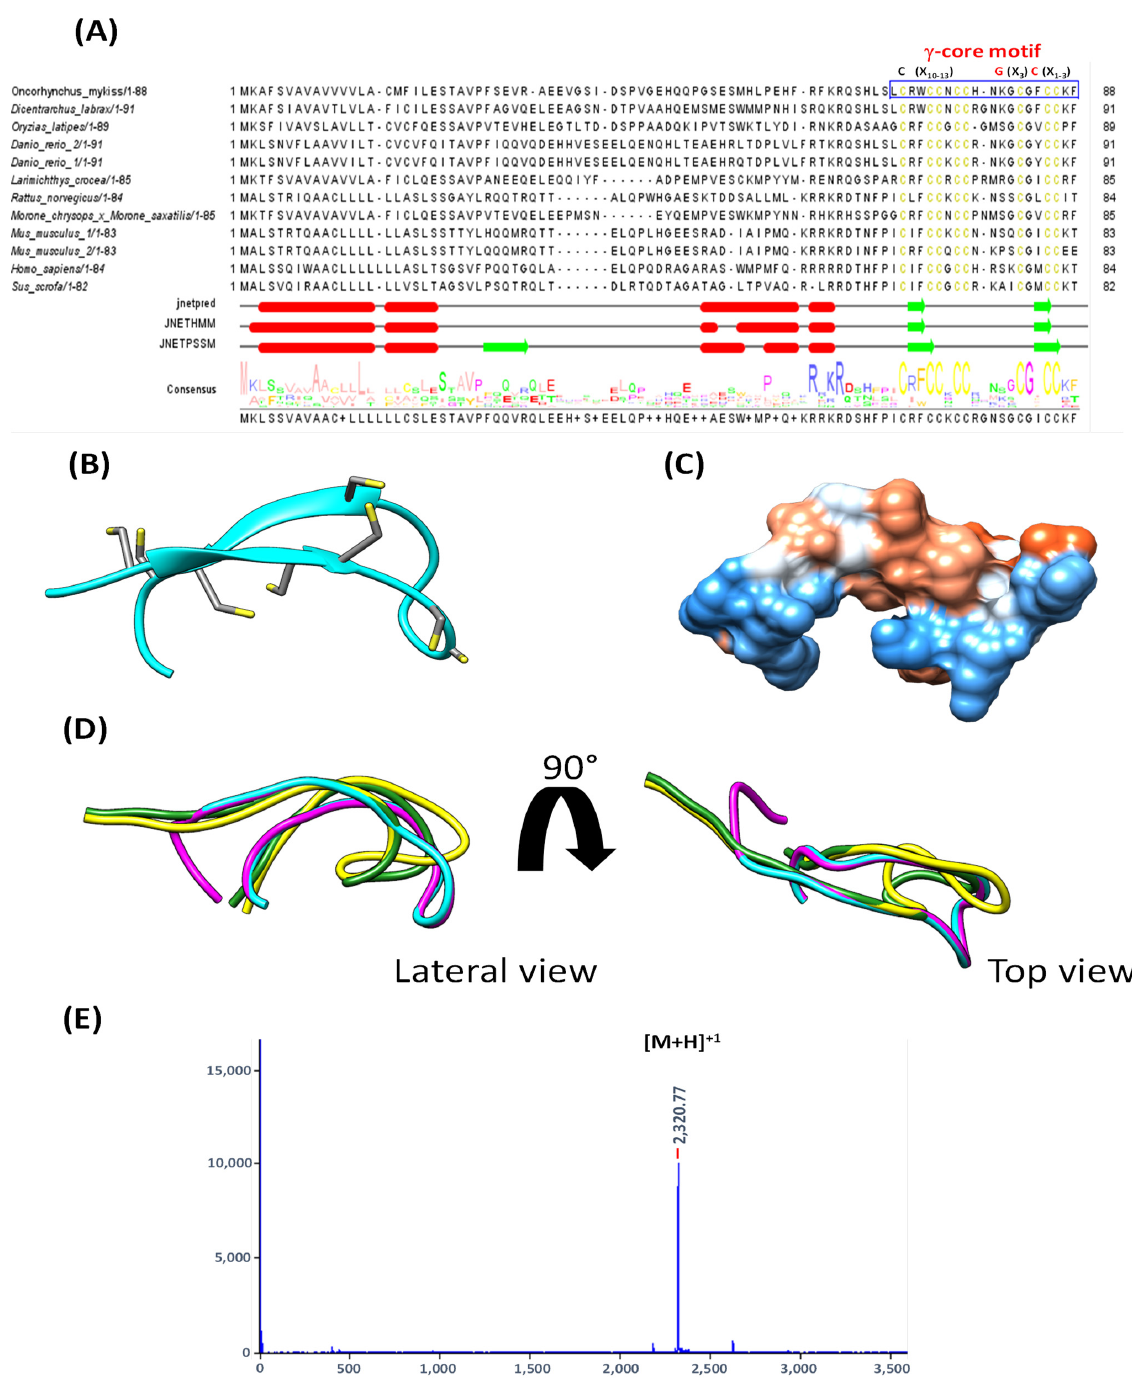
Figure 1. Hepcidin sequence analysis and synthesis of Hep20. ( A ) Multiple alignment analysis of hepcidin from fish and vertebrates. The blue box highlights the sequence of synthetic peptides (Hep20) from Oncorhynchus mykiss . Cysteine residues are shown in yellow. The GXC motif is shown in red, which is conserved in the different species being part of the γ -core motif. ( B ) A secondary structure prediction indicates that these peptides are composed of β -strand at the C-terminus. Cysteine residues of Hep20 are shown as stick representation (yellow). ( C ) Representation of hydrophobic (blue) and hydrophilic (red) surfaces of Hep20. ( D ) Superposition of C-terminus segment of Oncorhynchus mykiss (cyan), Oryzias latipes (green), Dicentrarchus labrax (yellow), and Homo sapiens (pink, 1M4F). ( E ) MALDI-TOF mass spectrum obtained for the synthetic Hep20 peptide, which confirms its molecular mass in an oxidized state showing the charged ion [M+H] + ( m / z